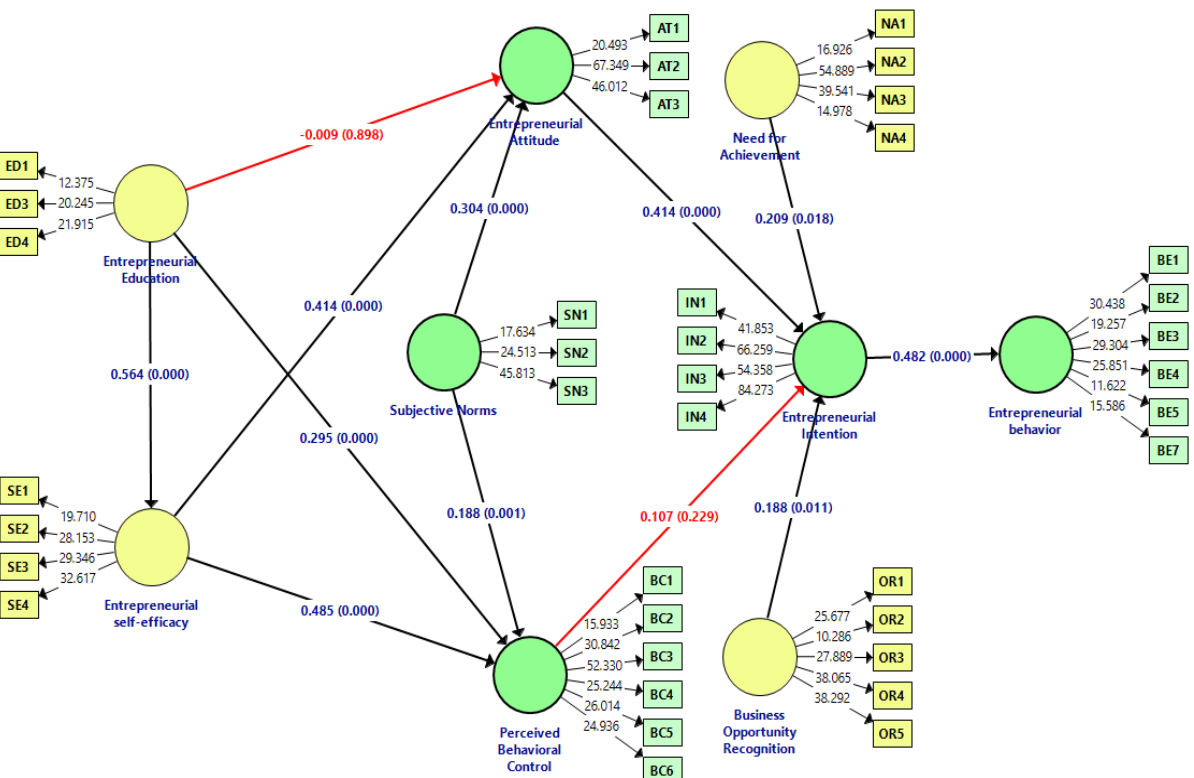
Figure 2. Hypotheses testing findings.